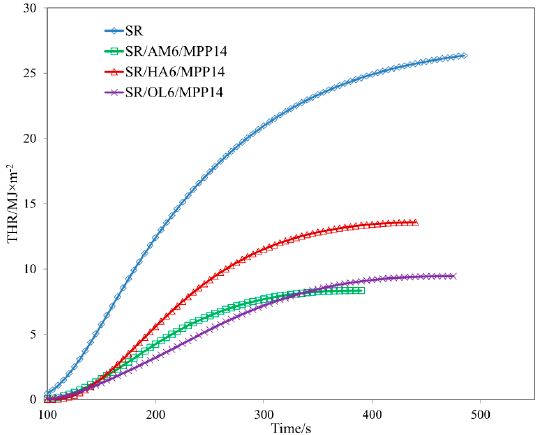
Figure 12. THR curves composites of SR/POSS/MPP.